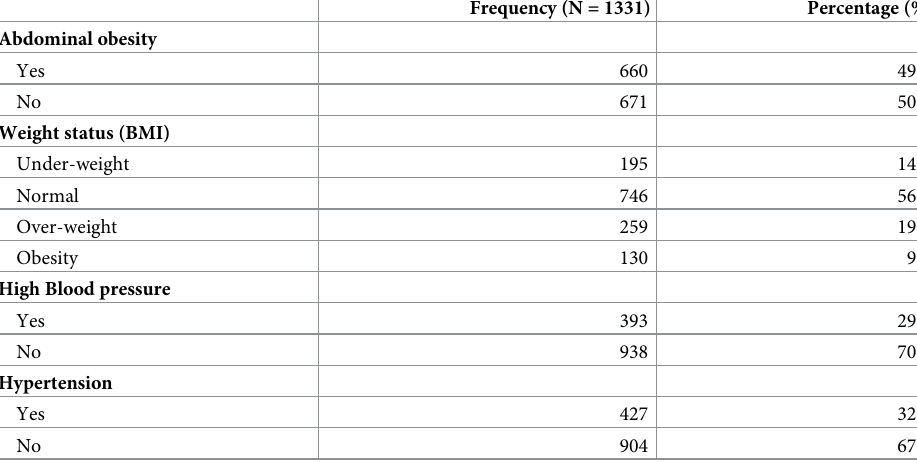
Table 2. Distribution of surveyed subjects according to biological risk factors in rural population of Tanv è and De´kanmey in Benin in 2019 (N =